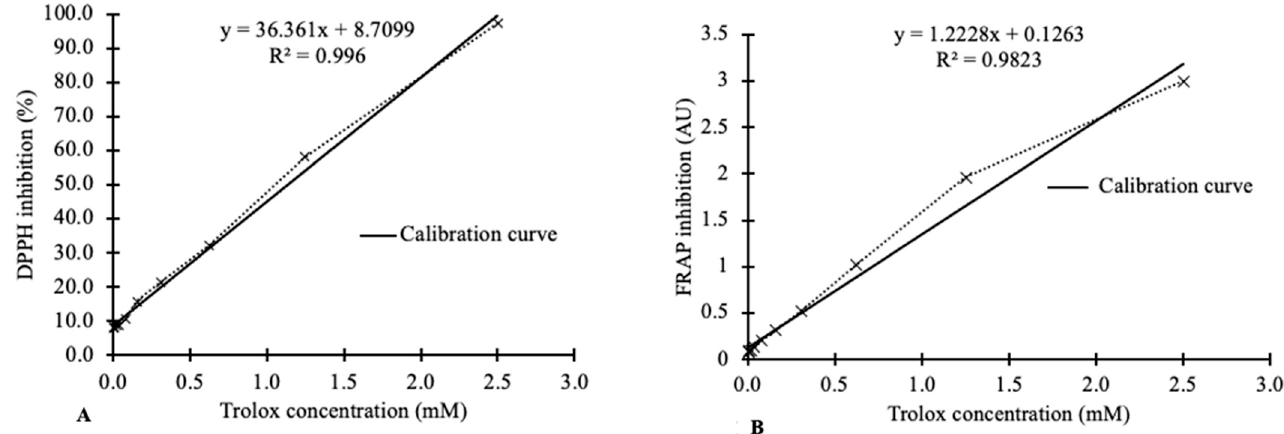
2,4,6-tri(2-pyridyl)-s-triazine) antioxidant assays.